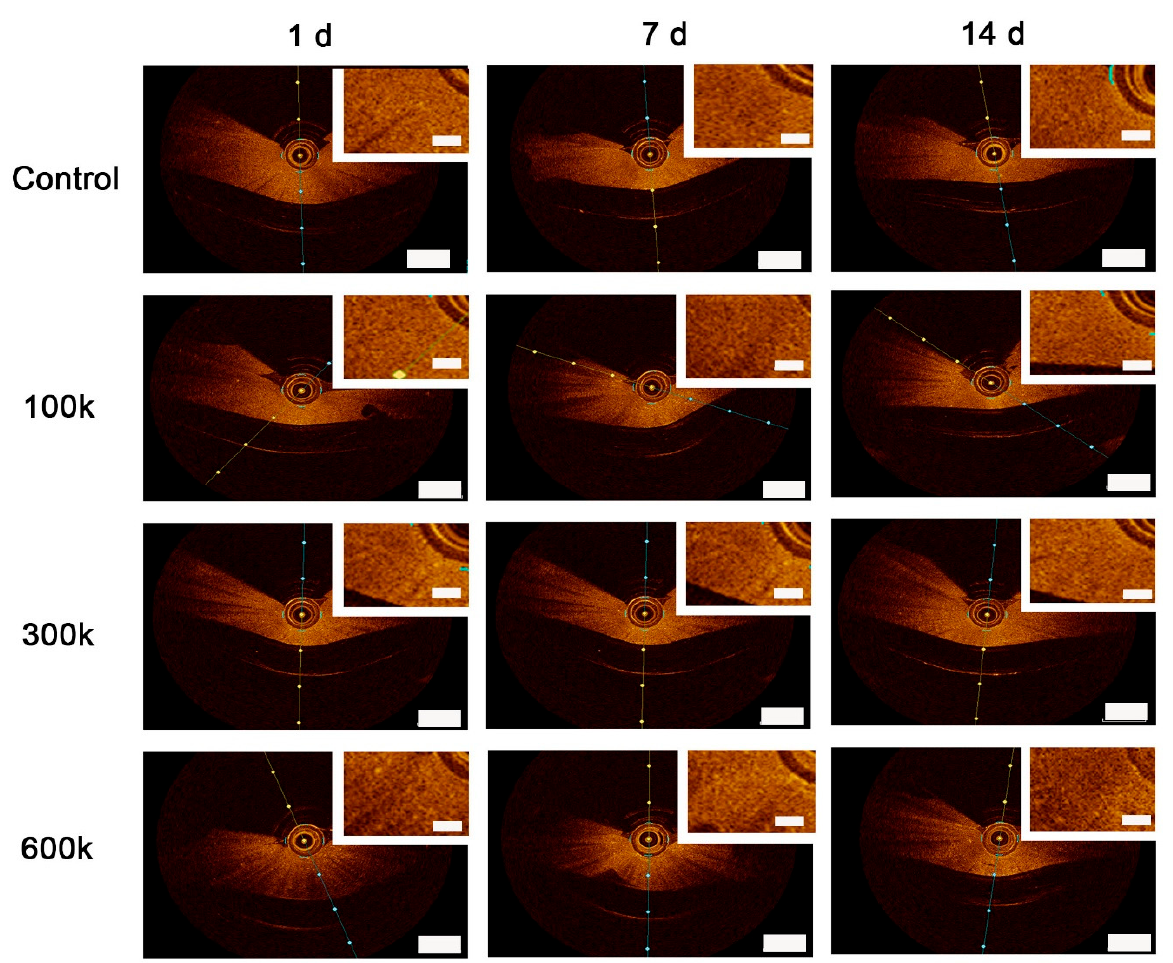
Figure 3. OCT analyses: HPMEC engaged in VNF in LV ECM hydrogels; 100k, 300k, and 600k HPMEC seeded in LV ECM hydrogel examined after 1 d, 7 d, and 14 d. As a control, hydrogels without HPMEC were used. Scale bars represent 1 mm (landscape view) and 0.2 mm (insets).